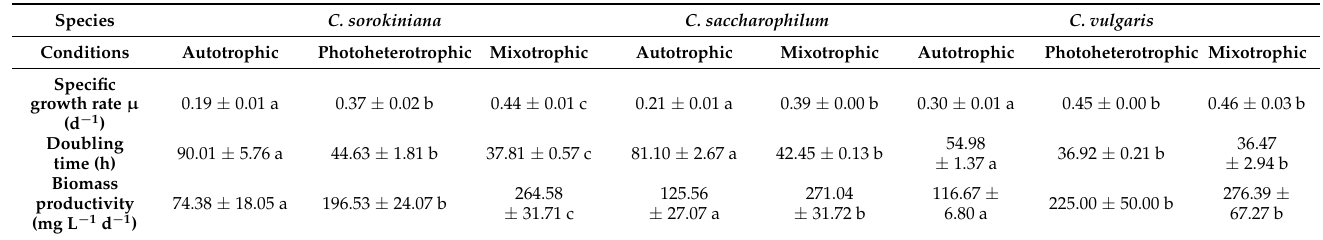
Table 1. Influence of trophic modes on basic growth parameters and biomass productivity of C. sorokiniana , C. saccharophilum , and C. vulgaris (the results are represented as mean values of measurements ± SD; the same letter means no significant differences; Tukey’s honestly significant difference test at p <